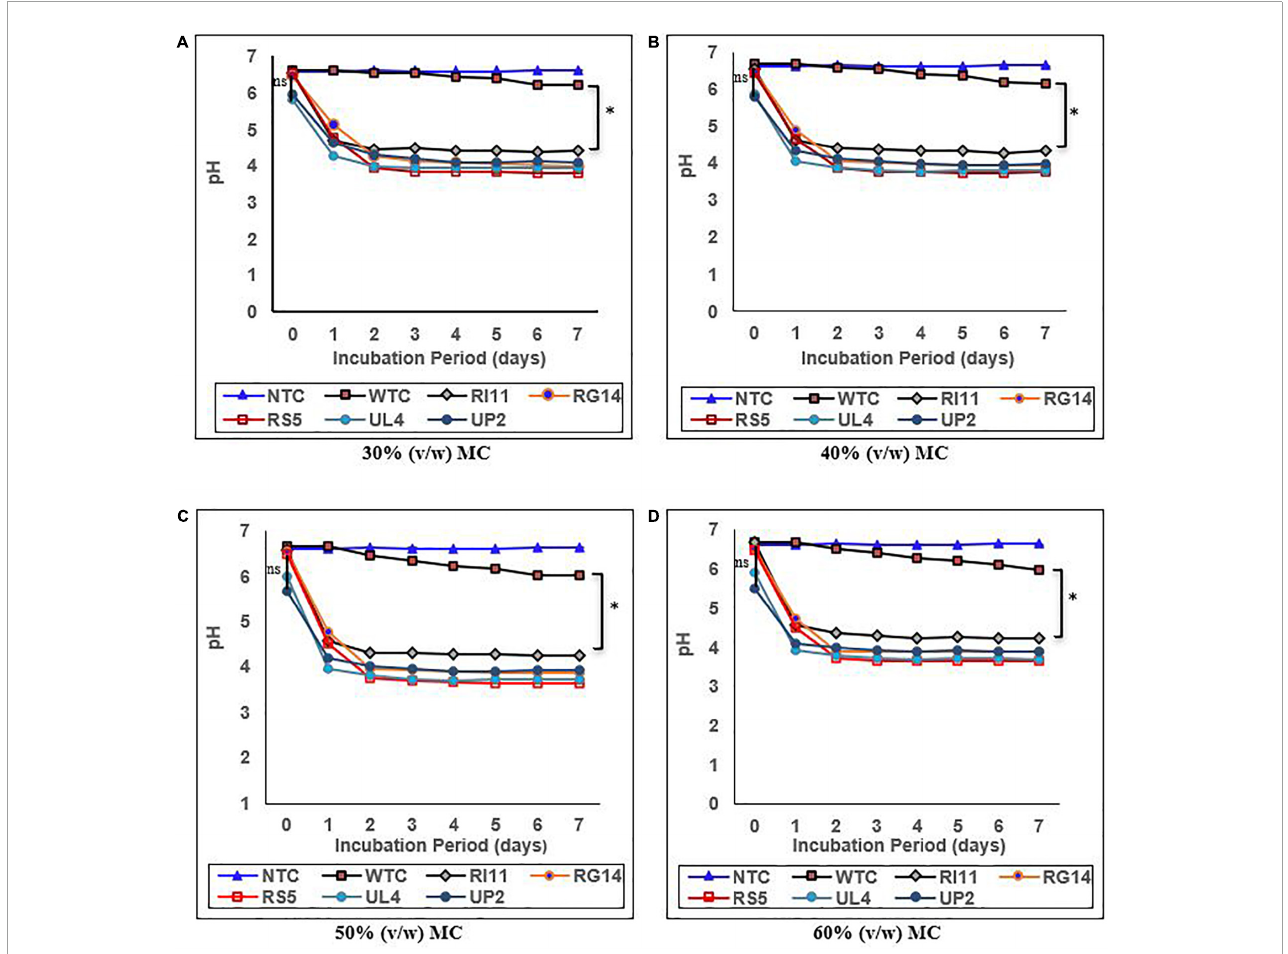
FIGURE1 Effect of moisture contents on pH of composite flour during 7 days of solid-state fermentation mediated by probiotic strains. Each value represents mean ± SEM, n = 3. NTC, non-treated control; WTC, water-treated control; R111, L. plantarum RI11; RG14, L. plantarum RG14; RS5, L. plantarum RS5; UL4, L. plantarum UL4; UP2, P. pentosaceus UP2. (A) 30% (v/w) moisture content, (B) 40% (v/w) moisture content, (C) 50% (v/w) moisture content, (D) 60% (v/w) moisture content. ∗ Indicate significant difference (p ≤ 0.05). ns Not significantly